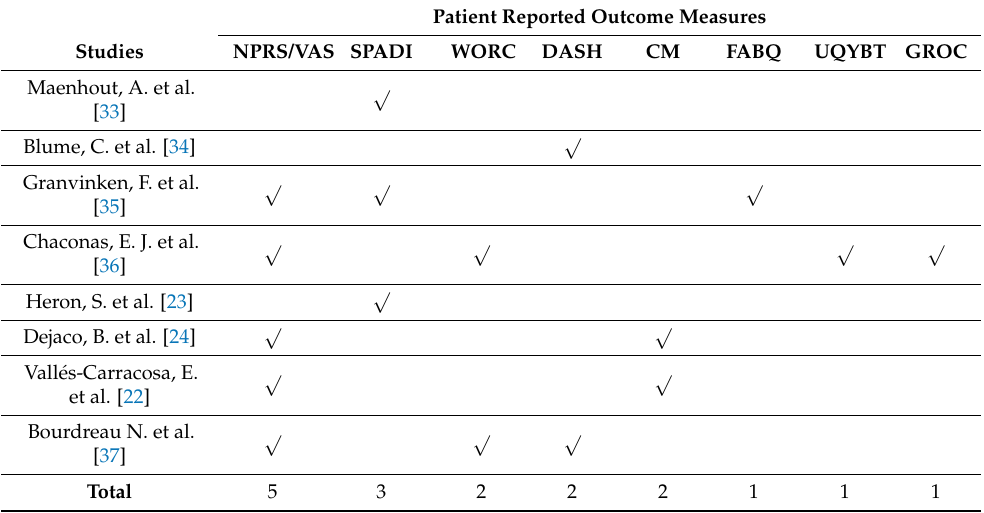
Table 6. PROMs used in selected